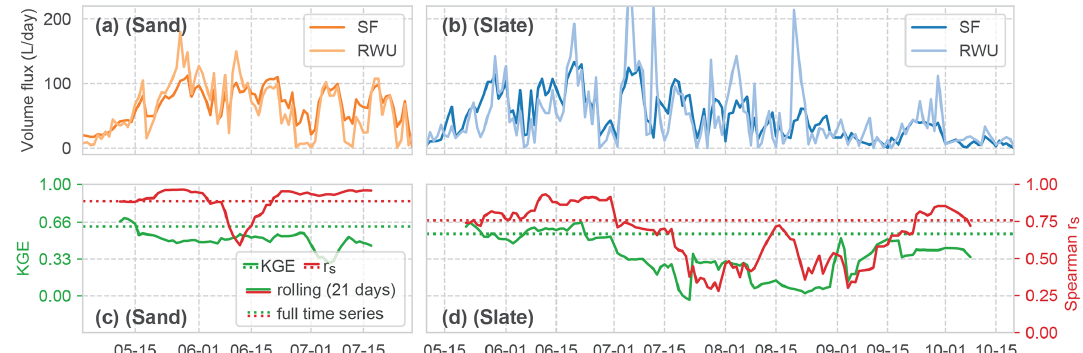
Figure 9. Comparison of the time series of calculated volume fluxes for RWU and SF at both sites (panels (a) and (b) for sand and slate, respectively). Correlations between the RWU and SF time series are shown in panels (c) and (d) , both as KGE and r s . The solid lines for the correlations show a 21d rolling mean; the dashed lines are the mean correlations for the whole time series.